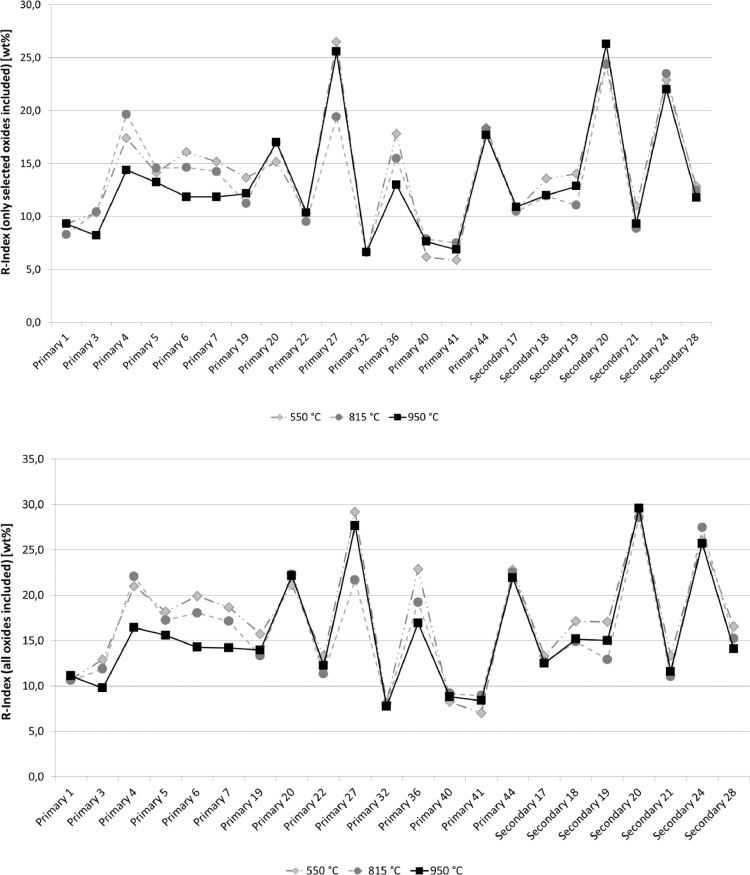
Comparison of the R-Indices for randomly selected SRF samples at different incineration temperatures; including all measured elementary oxides (above) as well as selected elementary oxides Al2O3, CaO, Fe2O3, SiO2 (below).